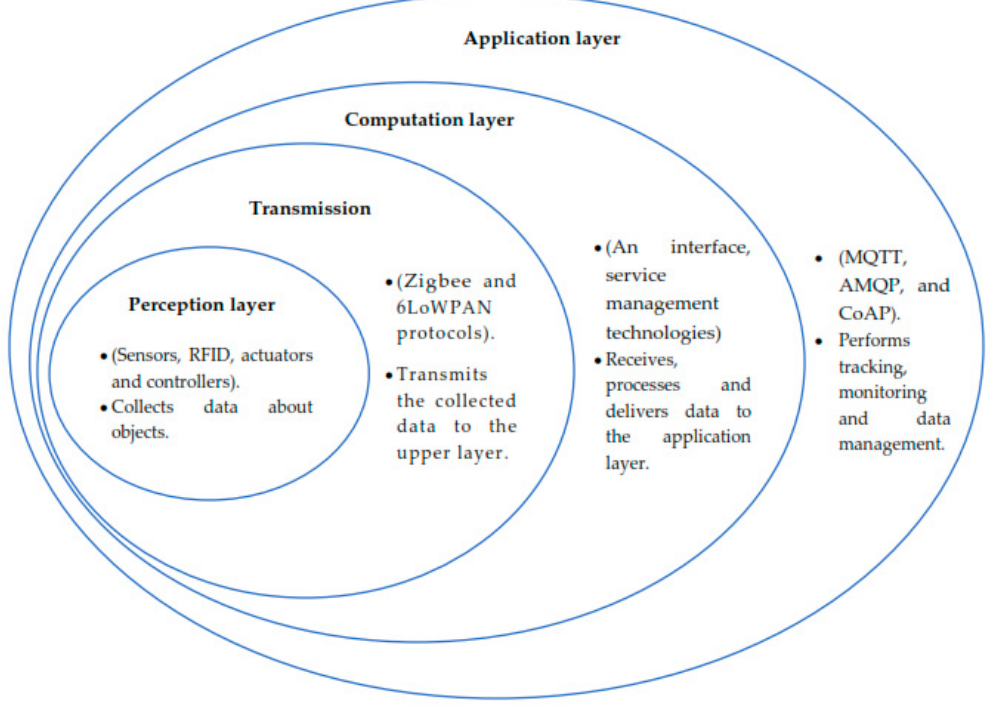
Figure 1. Architecture of IoT application.